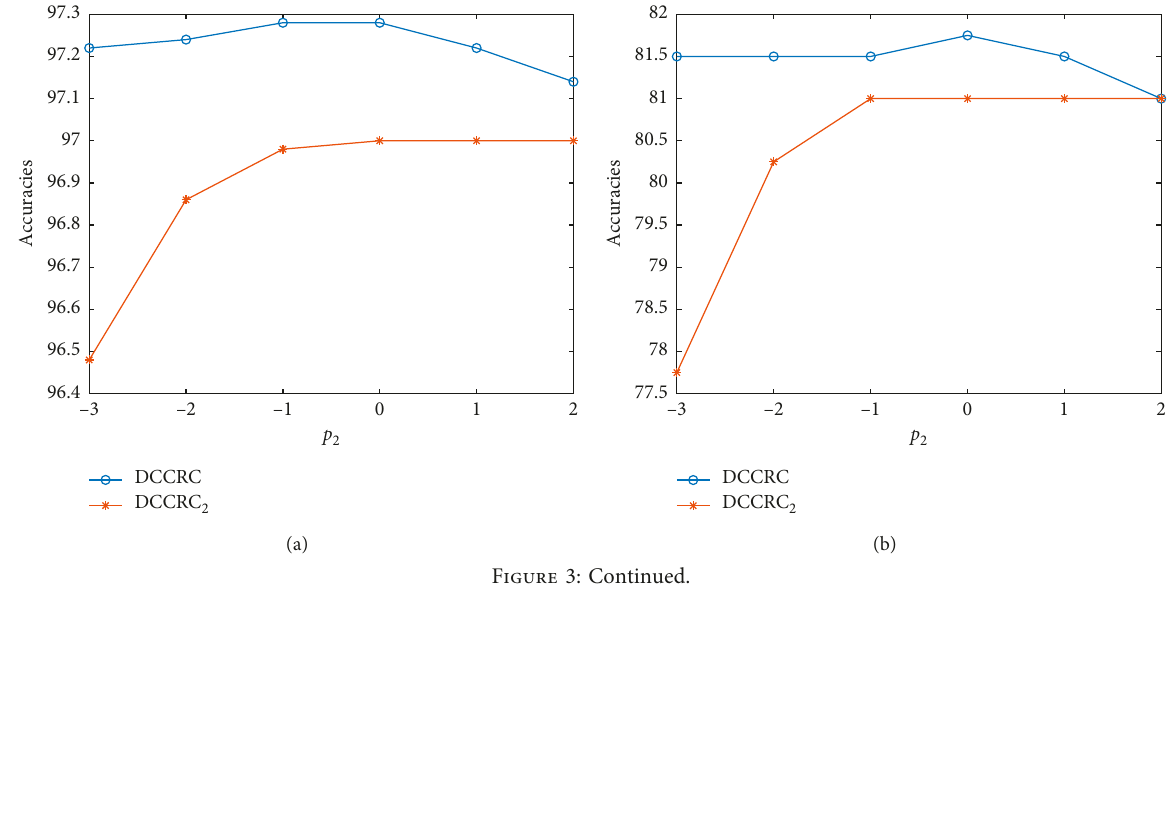
Figure 2: The comparisons of DCCRC and DCCRC ( l � 4). (c) YaleB ( l � 18). (d) Yale ( l � 2). (e) PIE29 ( l �